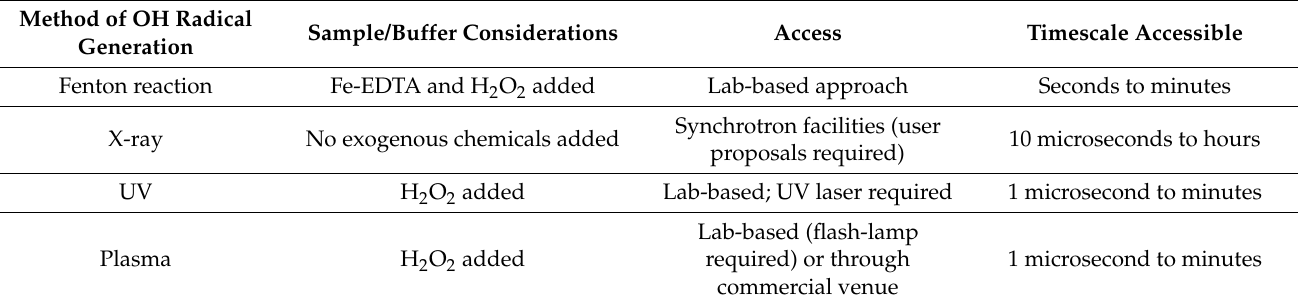
Table 1. Comparison between various OH-generation methods with buffer considerations, access, and timescales